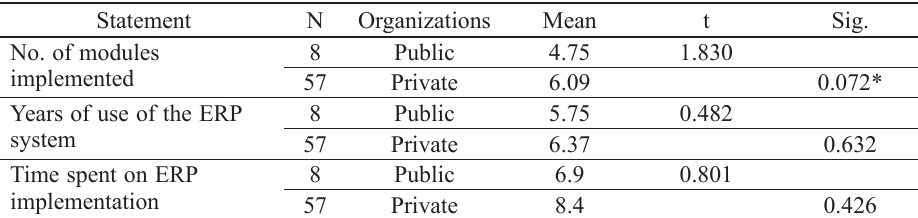
Table 6. T test regarding the utilization of ERP system by public/private